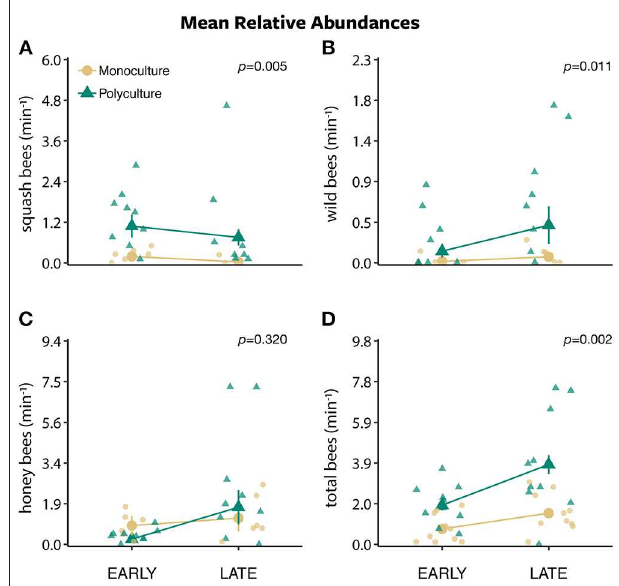
FIGURE 4 | The mean relative abundances ± standard error of (A) squash bees, (B) wild bees, (C) honey bees, and (D) total bees per minute along a 30m transect between two farm types (polyculture and monoculture) across early morning (sunrise) and late morning ( ∼